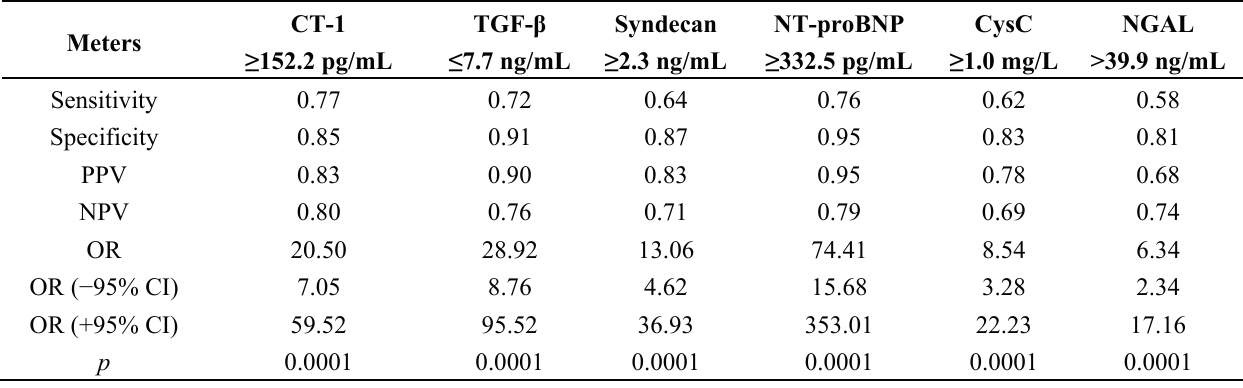
Table 3. Optimal cut-off points of biomarker levels for the occurrence of overt heart failure in patients with hypertension designated on the basis of ROC